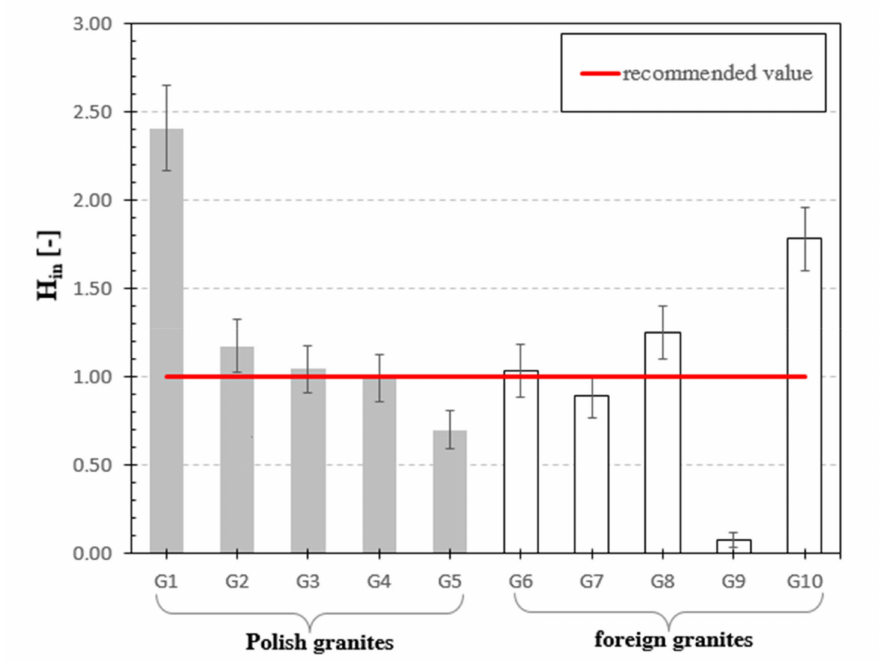
Figure 9. Internal Hazard Index for analyzed granite samples. The horizonal line indicates the recommended value of H in equal to 1 [24] for natural stones.